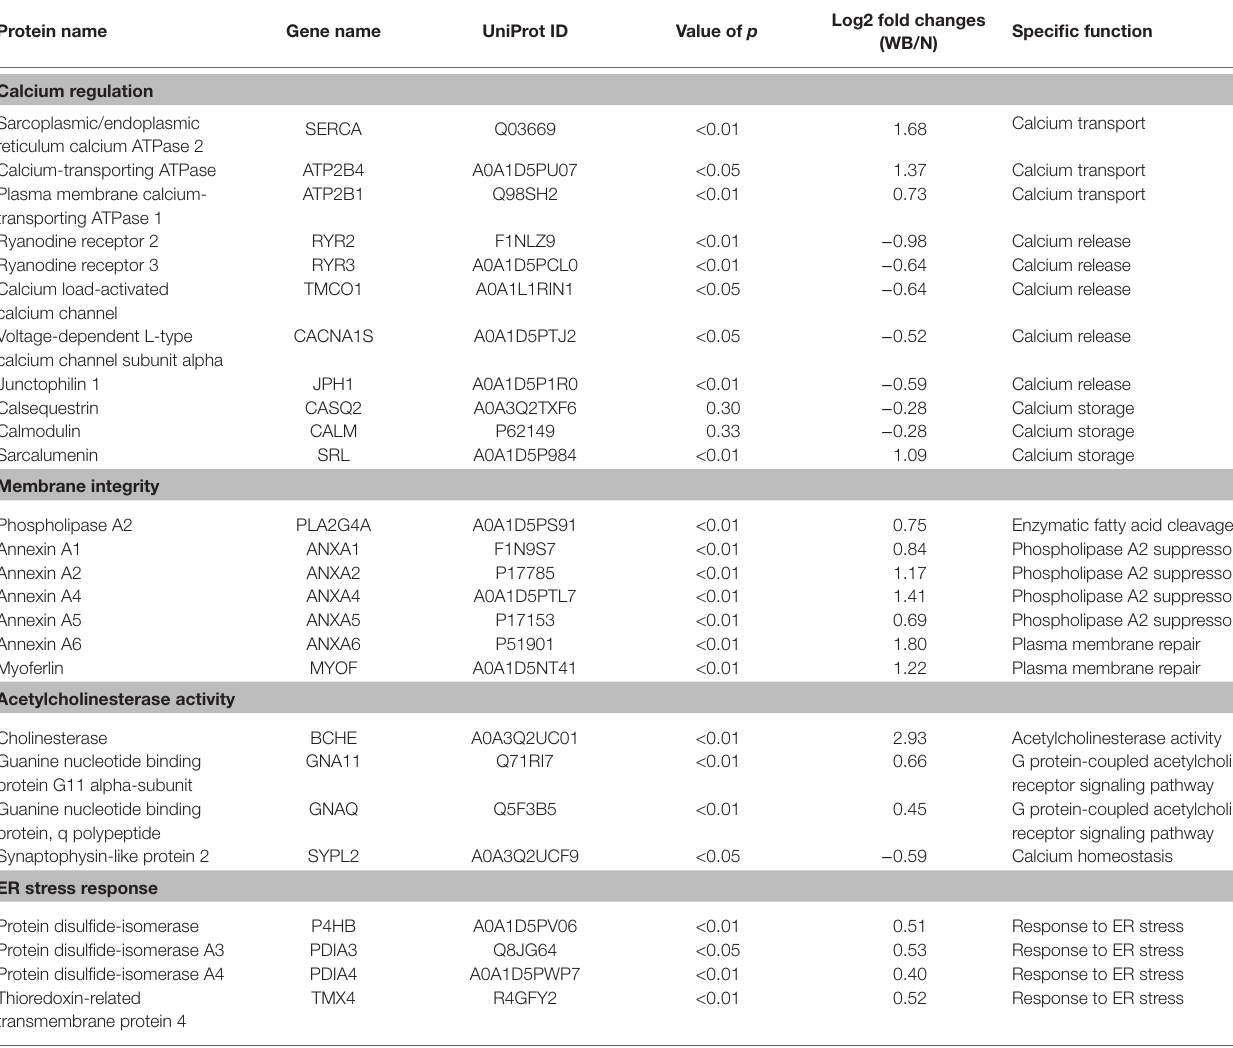
TABLE 2 | Representative proteins related to the calcium regulation, membrane integrity, acetylcholinesterase activity, endoplasmic reticulum (ER) stress response pathways in woody breast (WB) and normal (N) pectoralis major sarcoplasmic